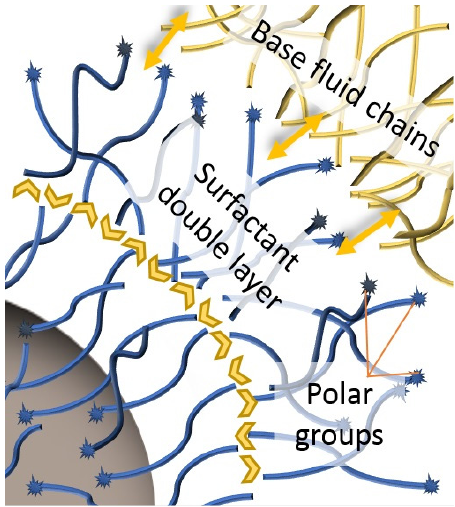
Figure 3. Hydrophilic double layer of surfactants and dielectric fluid.